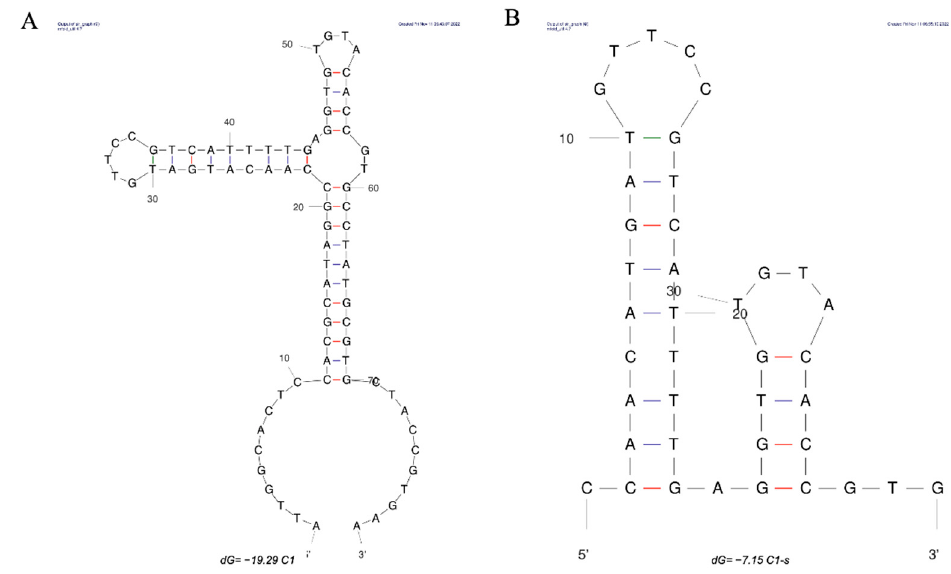
Figure 3. Secondary structure prediction of aptamer C1 ( A ) and aptamer C1-s ( B ) with their respective lowest Gibbs free energy value by mfold software.